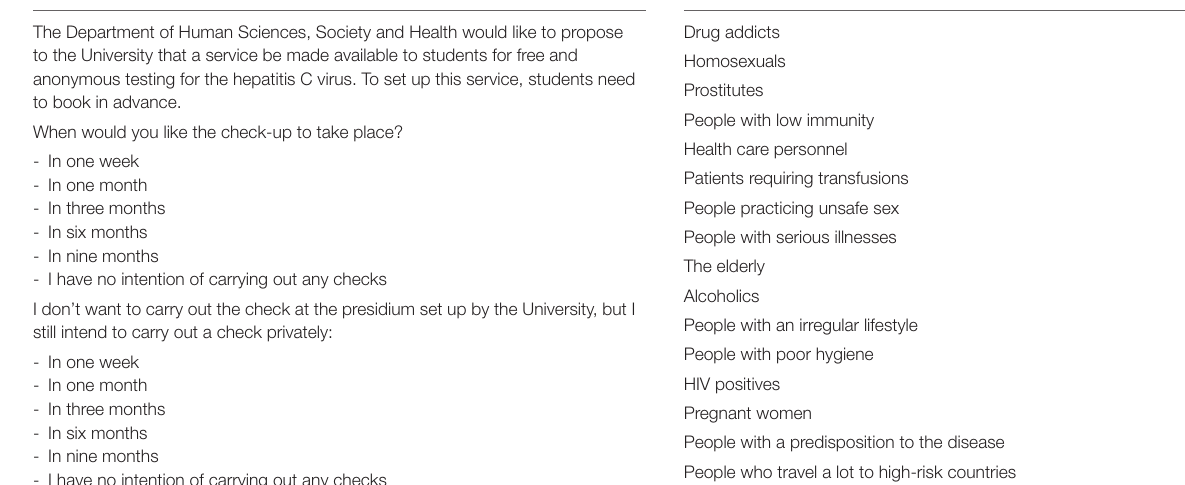
TABLE 4 | Diagnostic screening intention form. TABLE 5 | People believed to be at a higher risk of